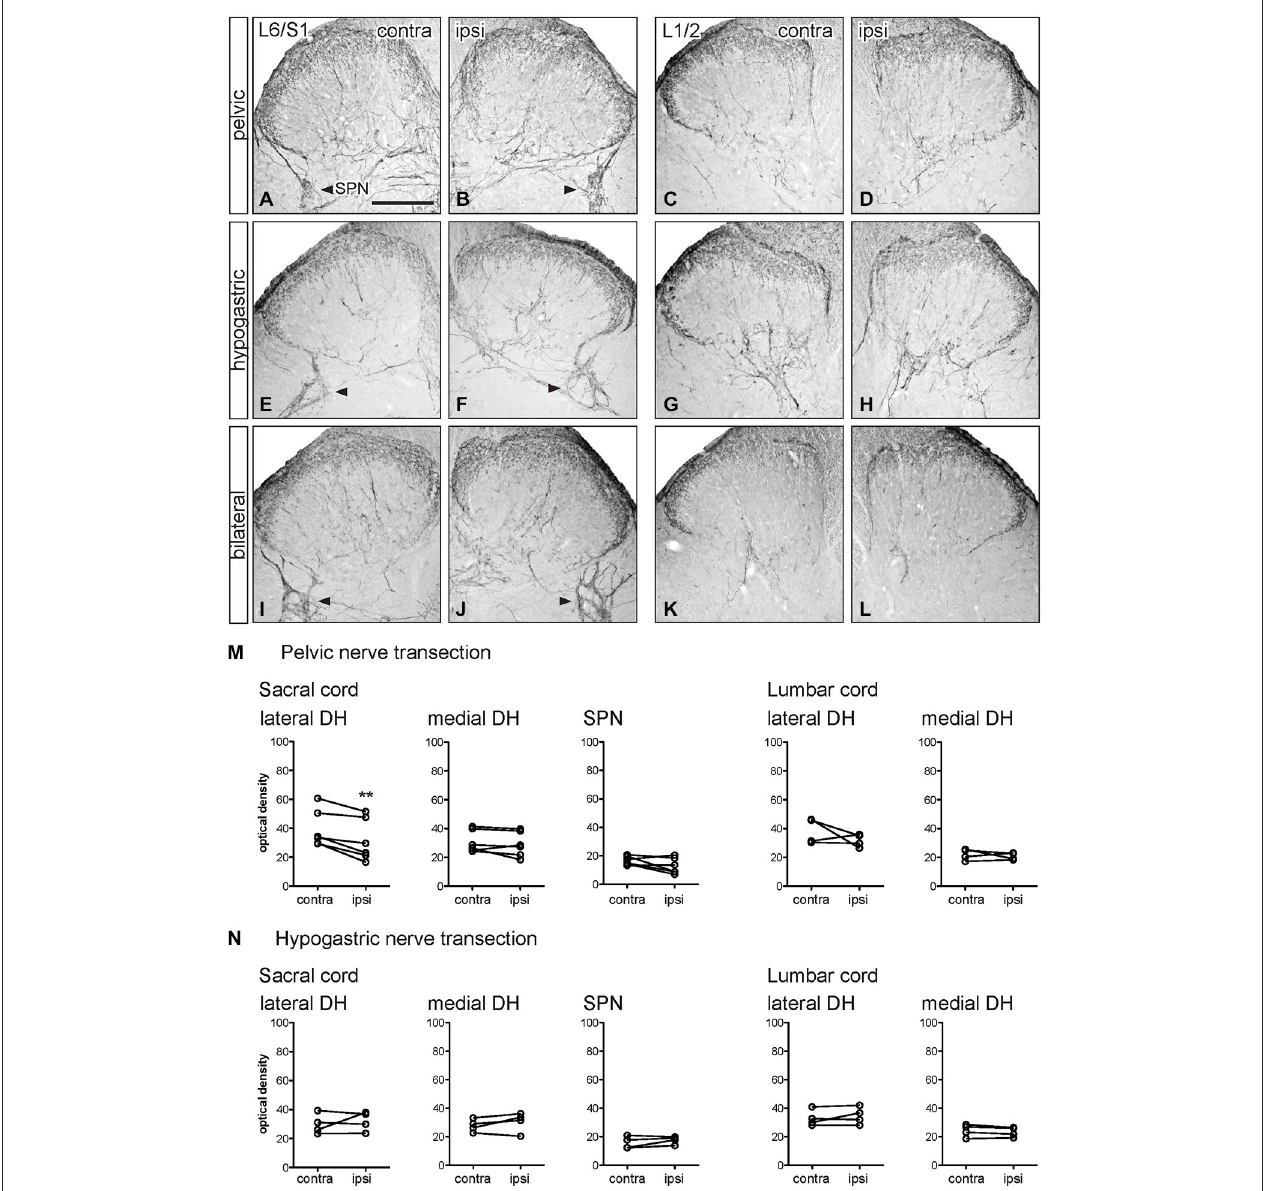
density analysis in sacral cord showed CGRP-IR decreased in only in the lateral dorsal horn. In lumbar cord, there was no change in CGRP-IR. (N) Hypogastric nerve transection had no effect on CGRP-IR in sacral or lumbar spinal cord. Data represents the mean ± SEM ( n = 6 rats for sacral data following unilateral pelvic nerve transection, n = 4 rats for lumbar data following unilateral pelvic hypogastric nerve transection) and was analyzed using a paired t -test. SPN (L6/S1) is indicated with arrowheads (A,B,E,F,I,J) . Scale bar represents 200 µ